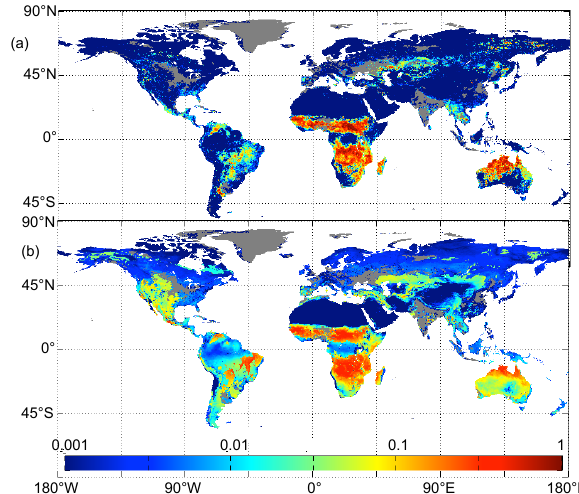
Fig. C1. Observed (a) and modelled (b) mean fire frequency (1yr − 1 ) for GFED-SF burned-area data. Model results are with optimised parameters using GFED-SF observations and the standard eight regions, all population densities. Grey areas were excluded.